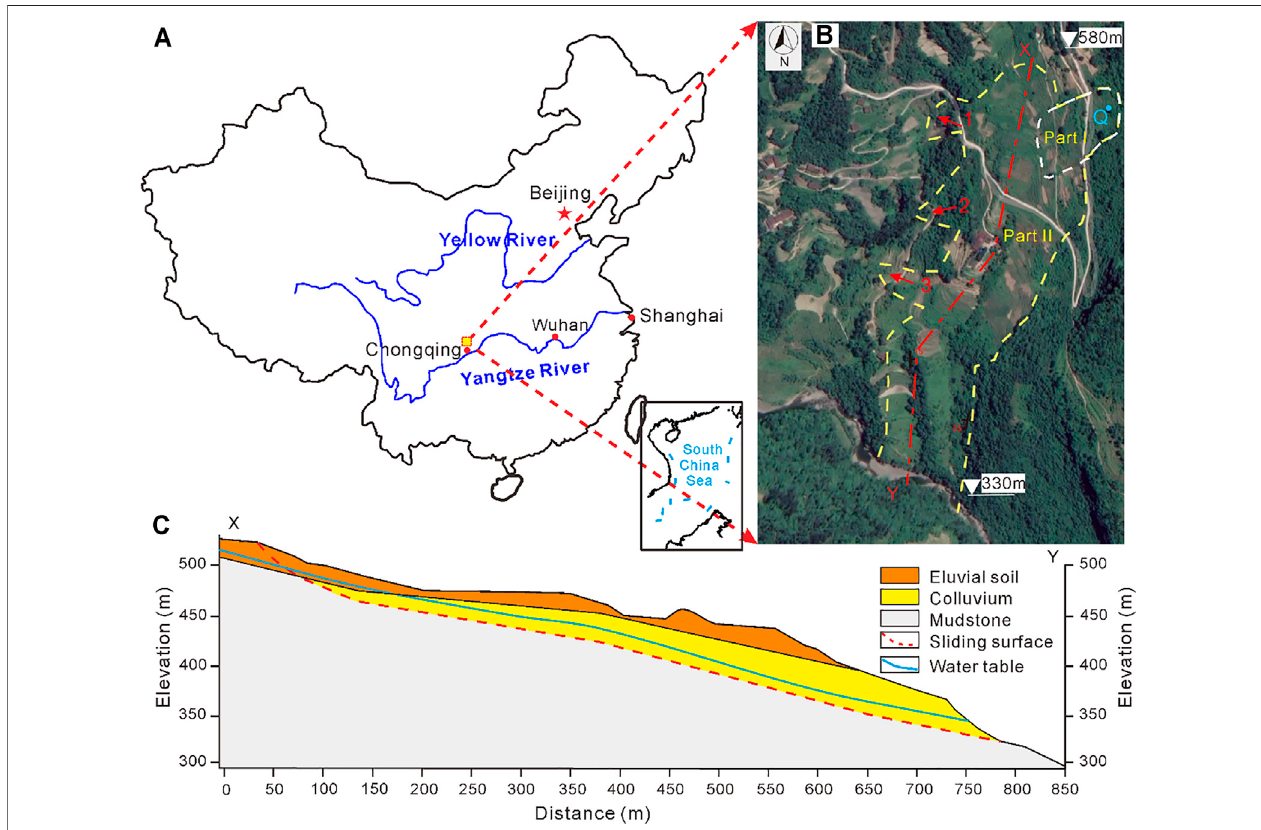
FIGURE 1 | Zhongbao landslide: (A) location of the landslide, (B) plane view and (C) vertical pro fi le after landslide failure.